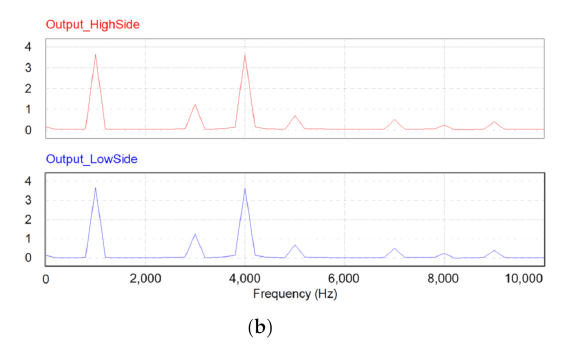
Figure 10. Frequency and FFT characteristics of Zone 1: ( a ) frequency characteristics of Zone 1